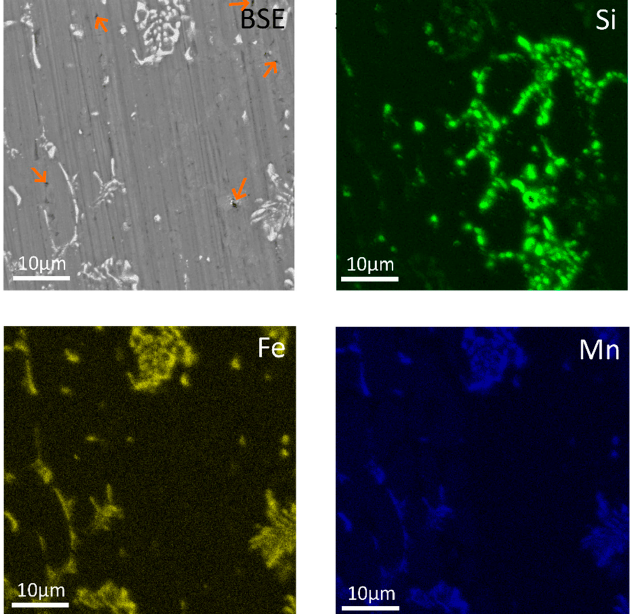
Figure 1. BSE image and elemental maps of main alloying elements in the as-cast strip. Arrows indicate selected small voids in the as-cast material in the BSE image.